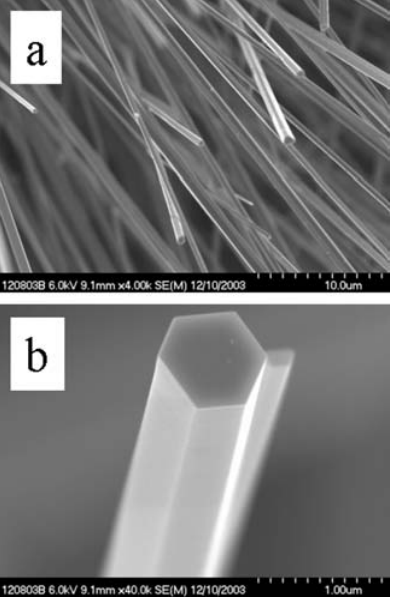
Figure 6. SEM image of (a) a single-crystal ZnO nanowire, lower resolution. (b) a single- crystal ZnO nanowire, higher